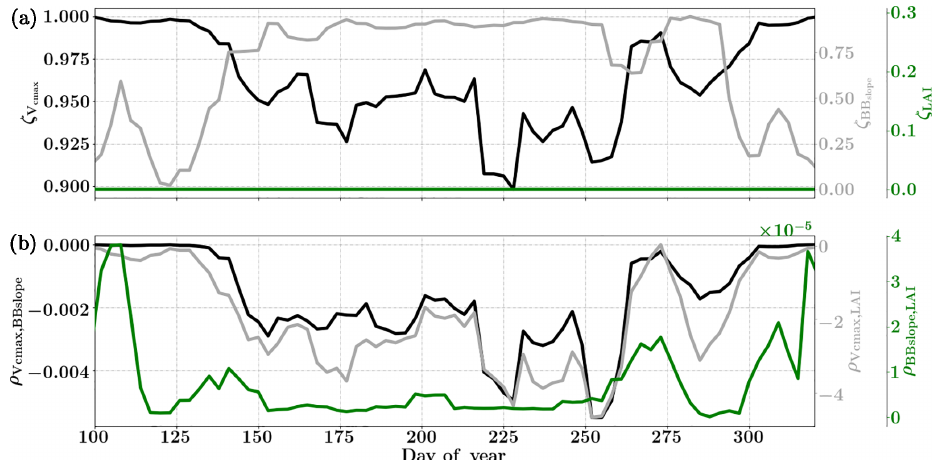
Figure 14. Figure showing the seasonal variability of the posterior error reduction ( ζ ) and correlation coefficient of the retrieved param- eter values of V cmax , BB slope and LAI for the Niwot Ridge site using a 3-day moving window inversion approach for the year 2010. Panel (a) shows the ζ V , ζ BB and ζ LAI for the entire growing season and (b) shows the correlation coefficients (normalized off- slope cmax diagonal elements of posterior error covariance matrix) among these variables. Both the ζ and correlation coefficients are computed using the final Jacobian matrix at the end of each retrieval